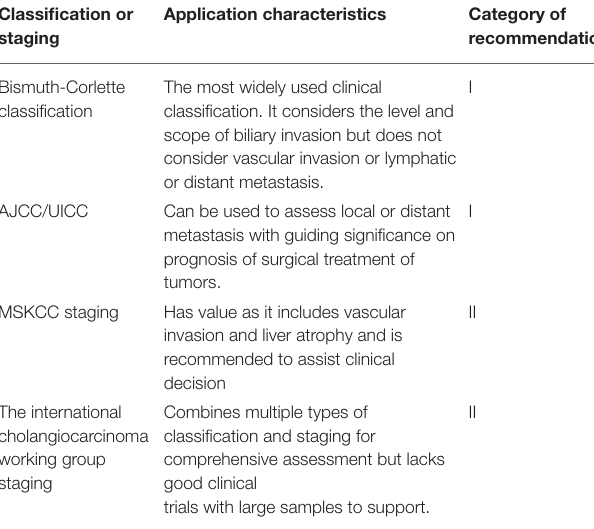
TABLE 4 | Preoperative classification and staging for hilar cholangiocarcinoma. Classification or